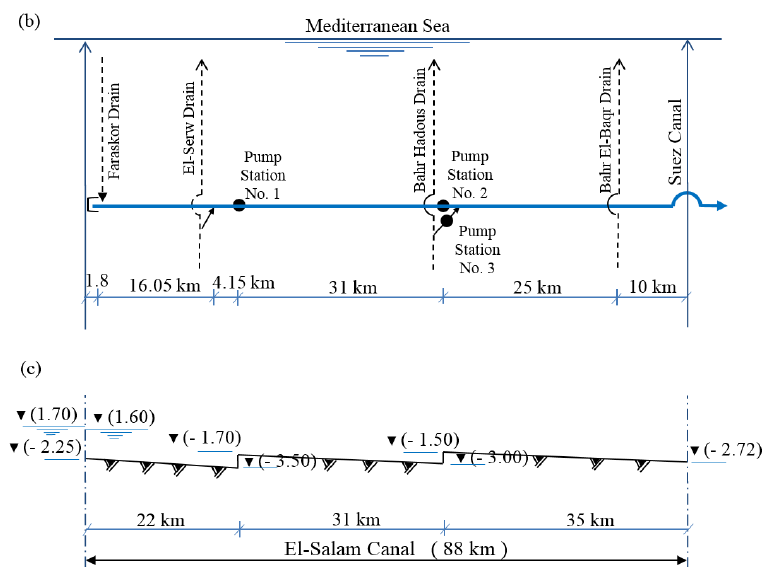
Figure 1. ( a ) The El-Salam Canal project; ( b ) schematic diagram; ( c ) longitudinal cross-section, of the El-Salam Canal connected with the Nile River and agricultural drains. Table 1. The average discharges from September 2012 to August 2014 and WQ parameters from September 2013 to August 2014 for the locations along the El-Salam Canal.